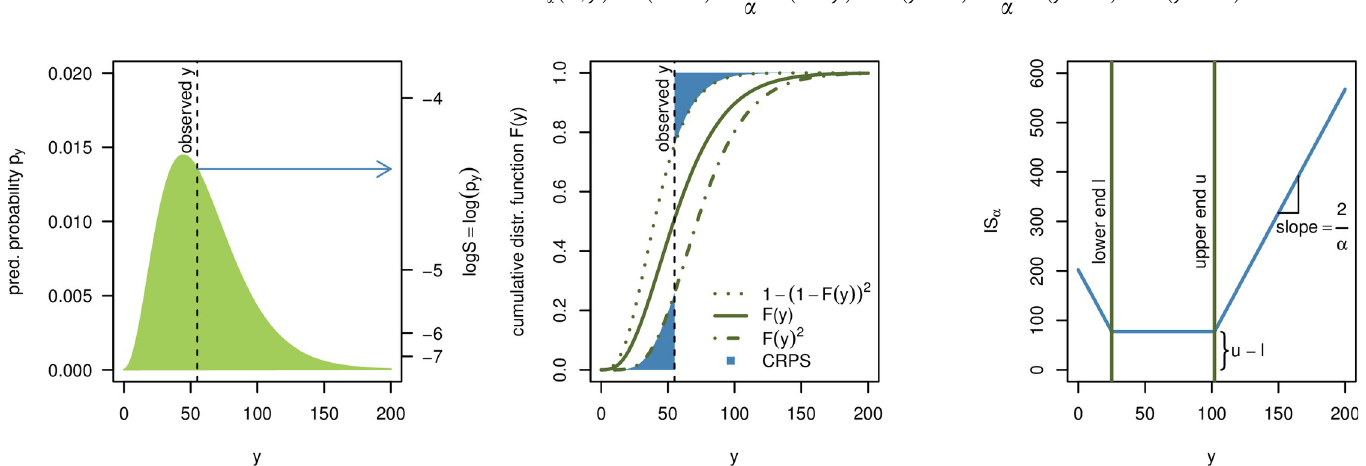
Fig 1. Visualization of the logS, CRPS, and IS. Left: The logarithmic score only depends on the predictive probability assigned to the observed event y (of which one takes the logarithm). Middle: The CRPS can be interpreted as a measure of the distance between the predictive cumulative distribution function and a vertical line at the observed value. Right: The interval score IS α is a piecewise linear function which is constant inside the respective prediction interval and has slope ± 2/ α outside of